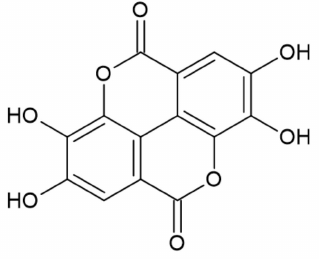
Figure 10. The structure of ellagic acid